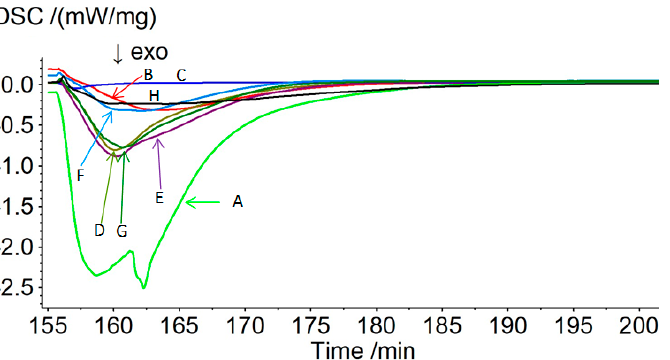
Figure 5. DSC signal recorded during the 500 °C oxidation step under dry air after pyrolysis. Curve identification is the same as in Figure 4. Table 3. TGA and DSC results elucidated from Figures 4 and 5,